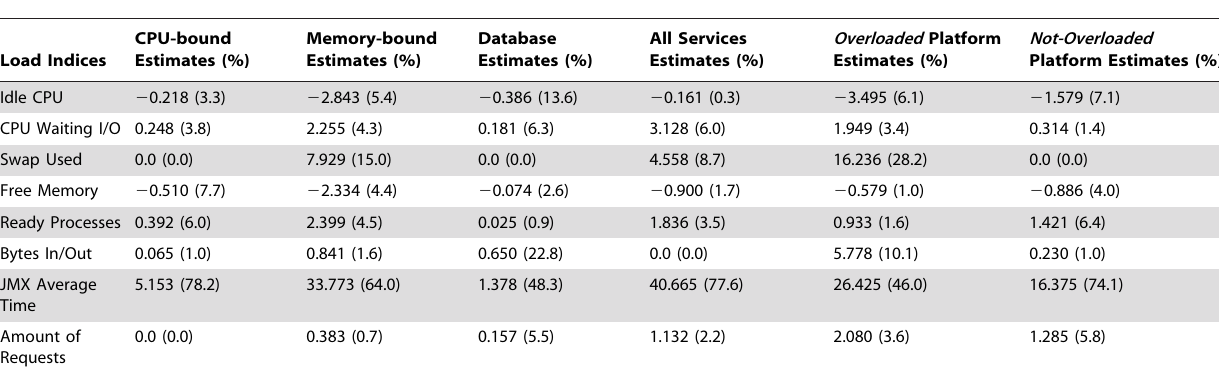
Table 2. Significance of the indices to explain the variability in the service runtimes evaluated through the stepwise-AIC method.